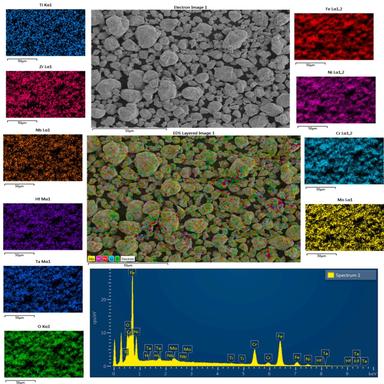
(a–c): SEM and EDS elemental mapping of (a) 1 % HEO, (b) 10 % HEO, (c) 20 % HEO.